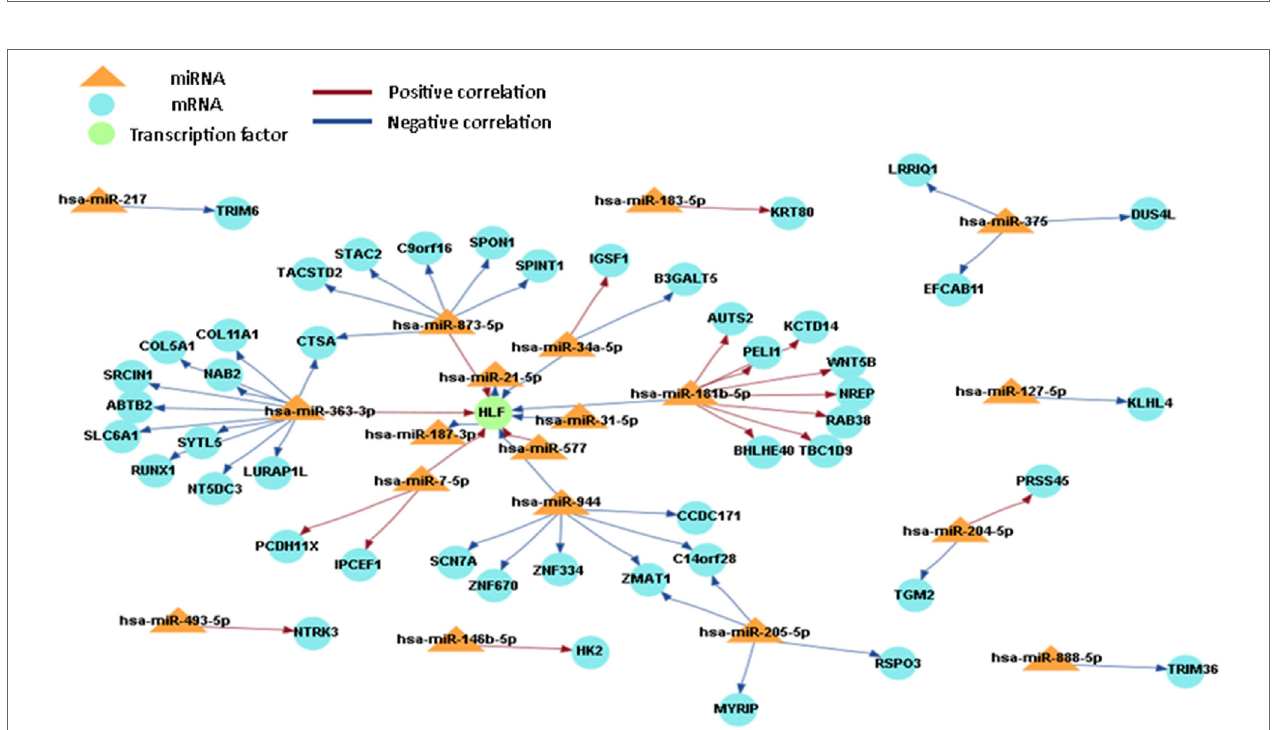
FigUre 7 | Grand view for 200 main significant microRNA (miRNA)–gene interaction that was generated using miRNA and gene that have significant expression in papillary thyroid carcinoma LNN versus their adjacent normal group.